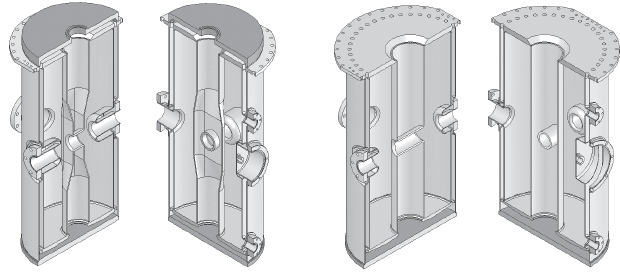
(cid:1) 0 : 17 (left) and (cid:1) (cid:1) 0 0